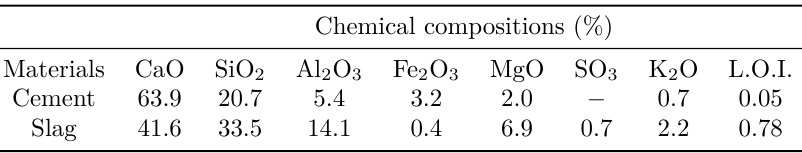
Table 1. Chemical compositions of slag and cement.